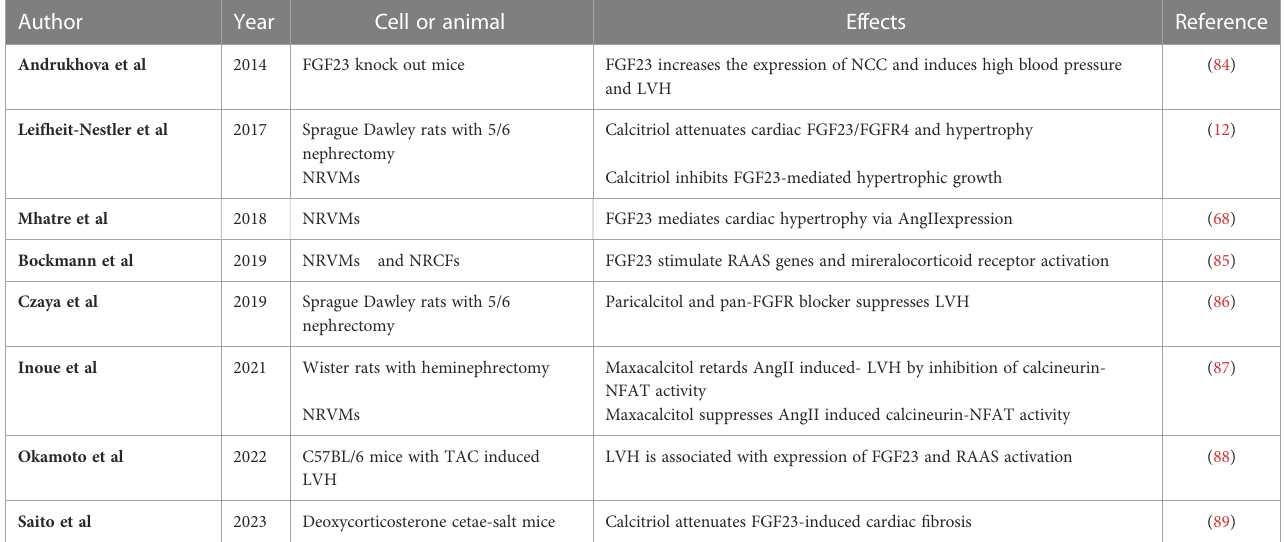
TABLE 2 Summary of the results of experimental studies regarding the indirect effects of FGF23 on LVH and myocardial fi